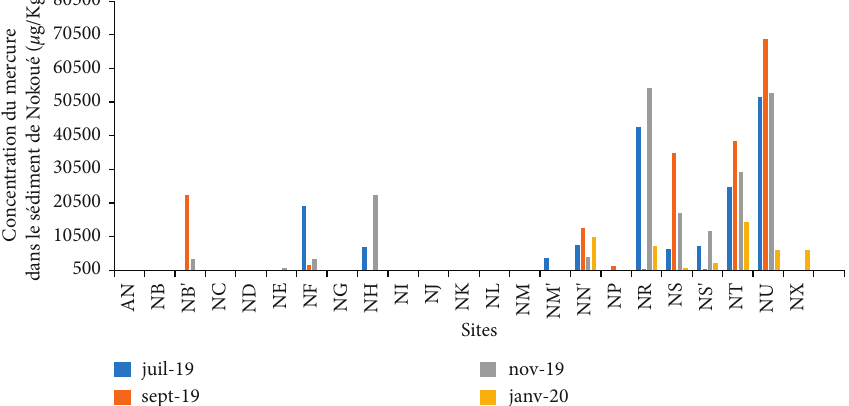
Figure 7: Variation in the content of mercury in the sediments of Lake Nokou´e.